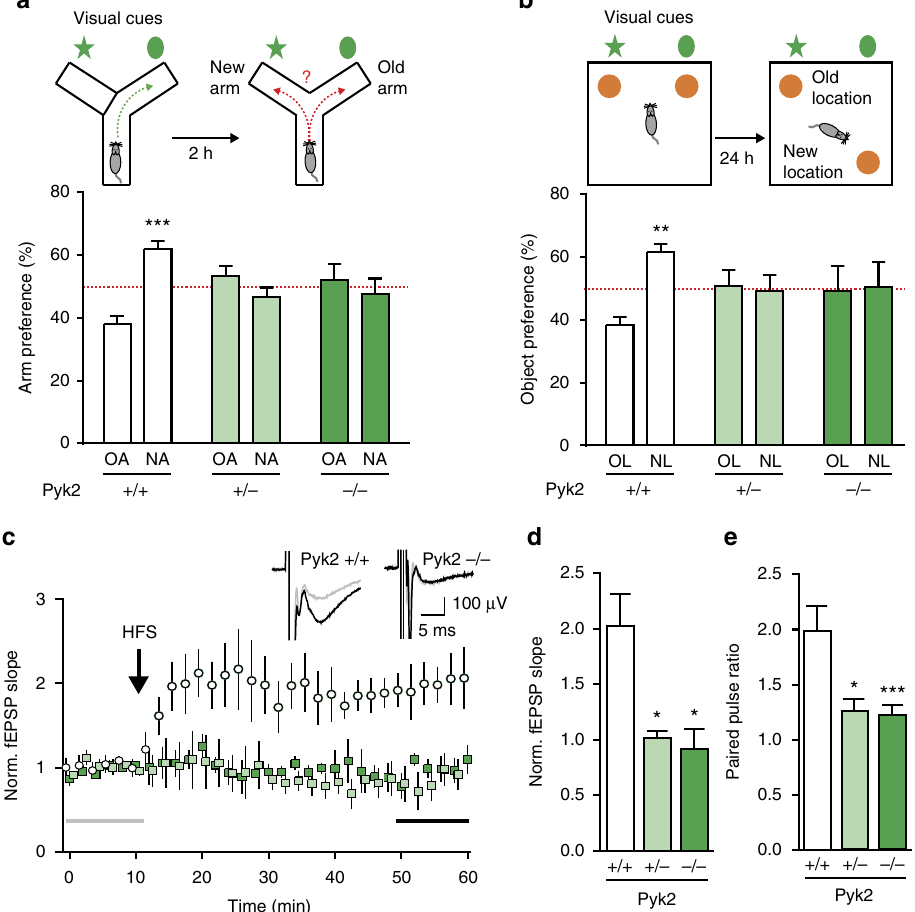
Figure 1 | Spatial learning and memory and CA1 LTP deficits in Pyk2 mutant mice. ( a ) In the spontaneous alternation test, Pyk2 þ / þ , Pyk2 þ / (cid:2) and Pyk2 (cid:2) / (cid:2) 3-month-old mice were placed for 10min in a Y-maze with one arm closed (upper left panel). Two hours later, they were put in the same maze with the new arm (NA) open and the percentage of time exploring the NA and the previously explored (old arm, OA) was compared (upper right panel). Two-way ANOVA interaction F (2,48) ¼ 11.6, P o 0.0001, OA versus NA Holm-Sidak’s test, Pyk2 þ / þ , t ¼ 4.6, P o 0.0001, Pyk2 þ / (cid:2) , t ¼ 1.58, Pyk2 (cid:2) / (cid:2) , t ¼ 0.81. ( b ) In the NOL test, the percentage of time exploring the displaced object (new location, NL, 24h after first exposure) and the unmoved object (old location, OL) was compared (upper panels). Two-way ANOVA interaction F (2,50) ¼ 3.41, P ¼ 0.041, OL versus NL Holm-Sidak’s test, Pyk2 þ / þ , t ¼ 3.1, P o 0.01, Pyk2 þ / (cid:2) , t ¼ 0.23, Pyk2 (cid:2) / (cid:2) , t ¼ 0.14. In a , b , 7–12 mice were used per genotype; the red dotted line indicates the chance level. ( c , d ) Schaffer collaterals were stimulated in hippocampal slices (one–three slices per animal) from 3-4-week-old Pyk2 þ / þ ( n ¼ 5), Pyk2 þ / (cid:2) ( n ¼ 6) and Pyk2 (cid:2) / (cid:2) ( n ¼ 4) mice, and fEPSP were recorded in CA1, before and after HFS (5 (cid:3) 1s at 100Hz). ( c ) Time course of fEPSP slope. Insets show typical traces before (grey) and 40min after (black) HFS in Pyk2 þ / þ and Pyk2 (cid:2) / (cid:2) slices. ( d ) Ten-min average of fEPSP slope 40min after HFS, normalized to the mean of 10-min baseline (corresponding time points are indicated in c by grey and black horizontal lines). Kruskal–Wallis ¼ 9.37, P ¼ 0.0024, post hoc analysis with Dunn’s multiple comparisons test. ( e ) Paired-pulse ratio (50-ms interval, see Supplementary Fig. 1e) at the same synapses. n ¼ 3–5 mice per group, two–four slices per mouse. Kruskal–Wallis ¼ 15.62, P ¼ 0.0004. In a – e , values are means þ s.e.m., * P o 0.05, ** P o 0.01, *** P o